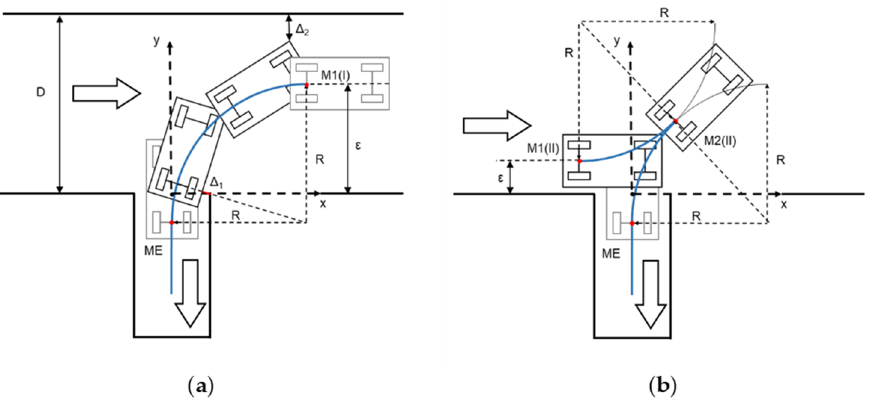
Figure 4. Diagrams for calculating the relevant points of the parking maneuver. ( a ) Maneuver I; ( b ) Maneuver II.